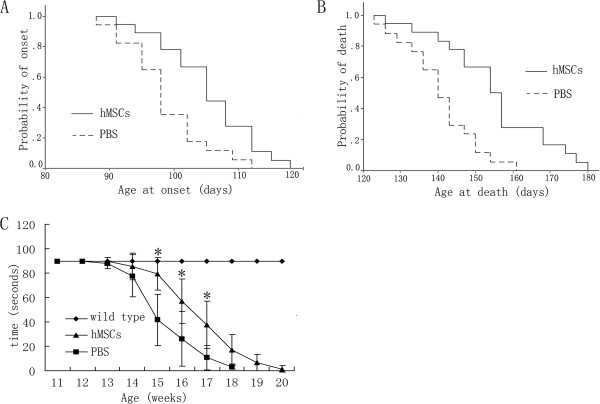
Human marrow stromal cell transplantation delayed disease progression and prolonged survival in SOD1 mice. Cumulative probability of disease onset (A) and survival (B) for Cu/Zn superoxide dismutase 1 (SOD1) mice beginning at 8 weeks of age treated with intrathecal injection of human marrow stromal cells (hMSCs), relative to PBS treatment. Survival and onset of SOD1 mice were significantly improved by hMSC treatment (*P <0.01). (C) Effect of hMSC treatment on motor performance in G93A SOD1 transgenic mice from 8 weeks of age. There was a significantly improved motor performance in G93A mice treated with hMSC injection from 15 to 17 weeks of age (*P <0.01). Values are mean ± standard error of the mean.